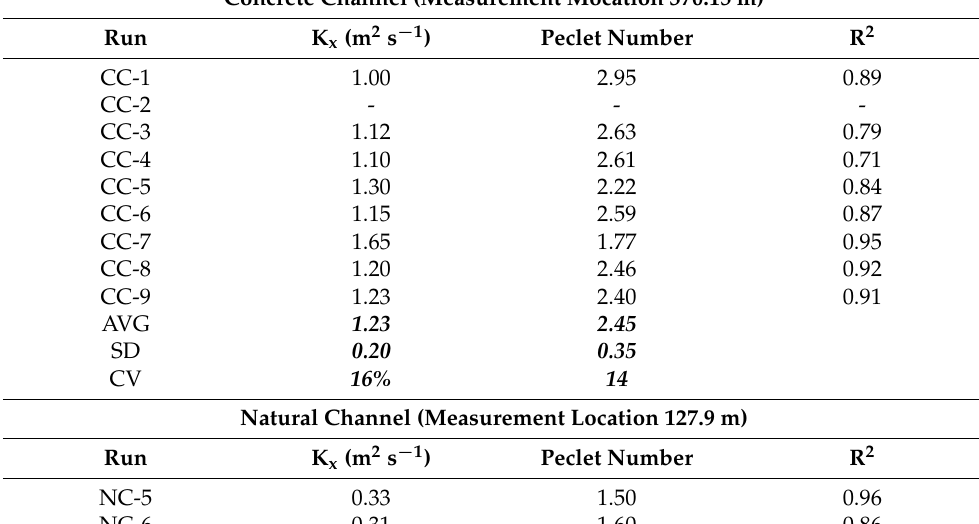
Table 2. Observed longitudinal dispersion coefficients and Peclet numbers for the concentration curves located in the equilibrium zone.